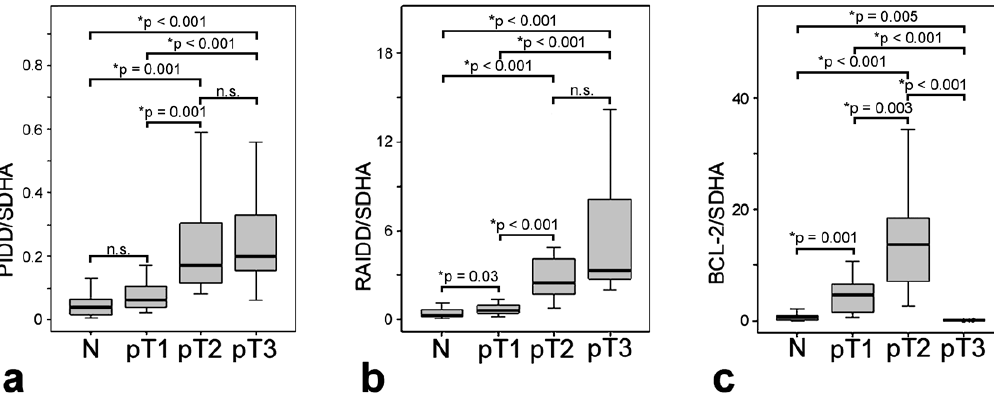
Fig. 3. SDHA-normalized PIDD, RAIDD and BCL-2 mRNA expression in non-neoplastic renal tissue and in RCCs of different tumour stages. (a) Significantly increased relative total PIDD mRNA expression (i.e. SDHA-normalized total PIDD expression) in pT2 and pT3 RCCs when compared to non-neoplastic renal tissue (N) and pT1 RCCs. No difference between relative total PIDD mRNA expression in RCCs infiltrating beyond the kidney borders (pT3) and pT2 RCCs. (Significant results are indicated ∗ p .) (b) Significantly increased relative RAIDD expression (i.e. SDHA-normalized RAIDD expression) in pT1 RCCs when compared to non-neoplastic renal tissue. Further increase in relative RAIDD mRNA expression in pT2 RCCs compared to pT1 RCCs. No difference between relative RAIDD mRNA expression in pT3 and pT2 RCCs. (c) Significantly increased relative BCL-2 expression (i.e. SDHA-normalized BCL-2 expression) in pT1 RCCs when compared to non-neoplastic renal tissue. Further increase in relative BCL-2 mRNA expression in pT2 RCCs compared to pT1 RCCs. Significantly decreased relative BCL-2 mRNA expression in pT3 RCCs compared to non-neoplastic renal tissues, pT1 as well as pT2 RCCs. (Significant results are indicated ∗ p